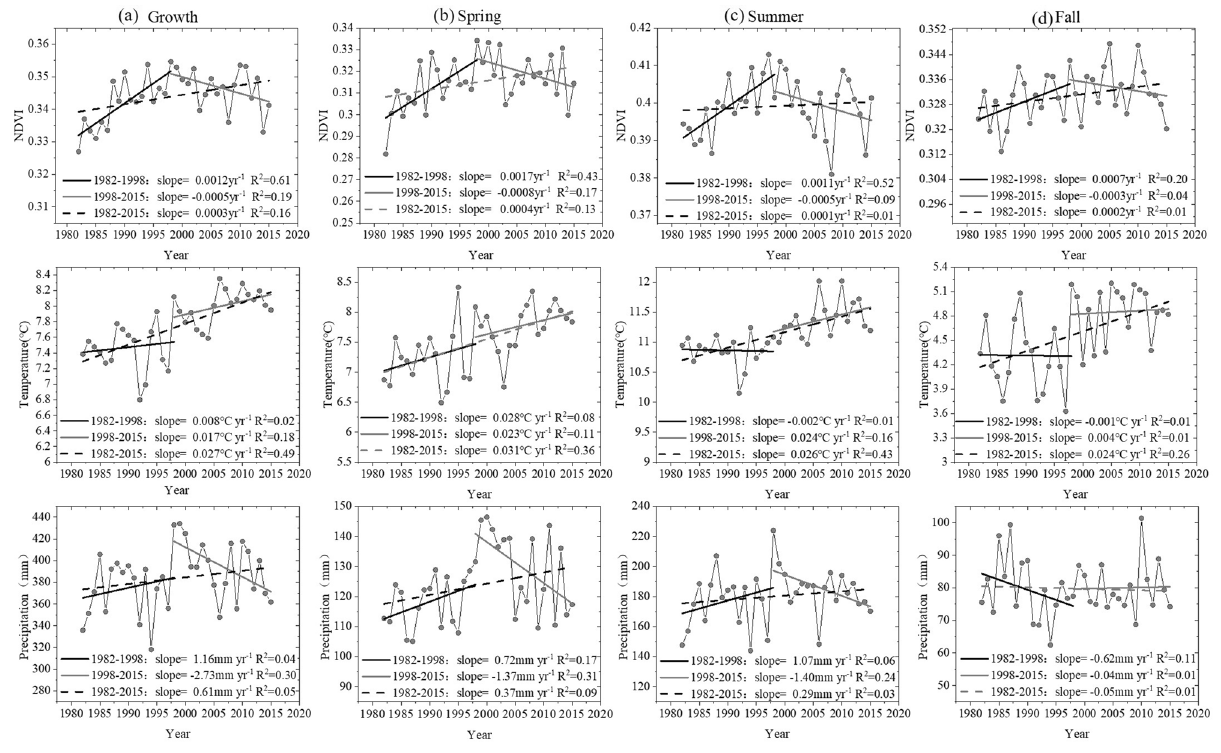
Figure 2. Inter-annual dynamics of growing season NDVI, air temperature, and precipitation in HMA from 1982 to 2015 (Generated by Origin 2020b, URL: https:// www. origi nlab.